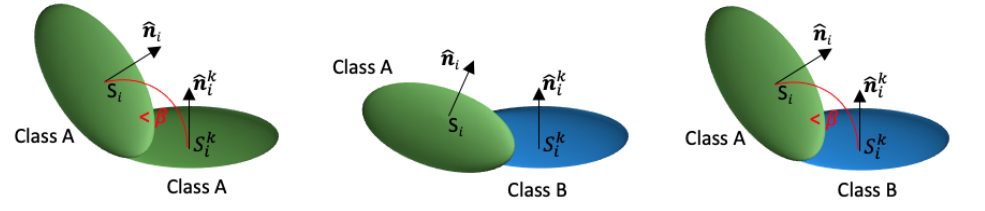
Figure 3. Illustrating the stopping cases to ensure the preservation of sharp features and avoid classes interference in the splats